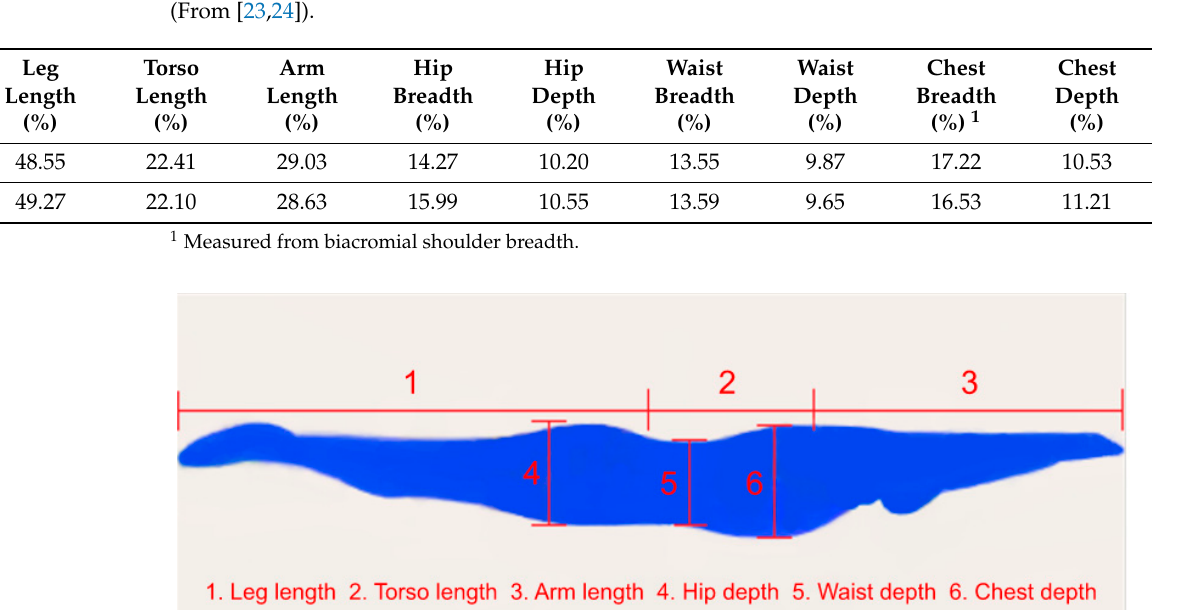
Figure 1. Anthropometric Features Measured on Female Side View Model.